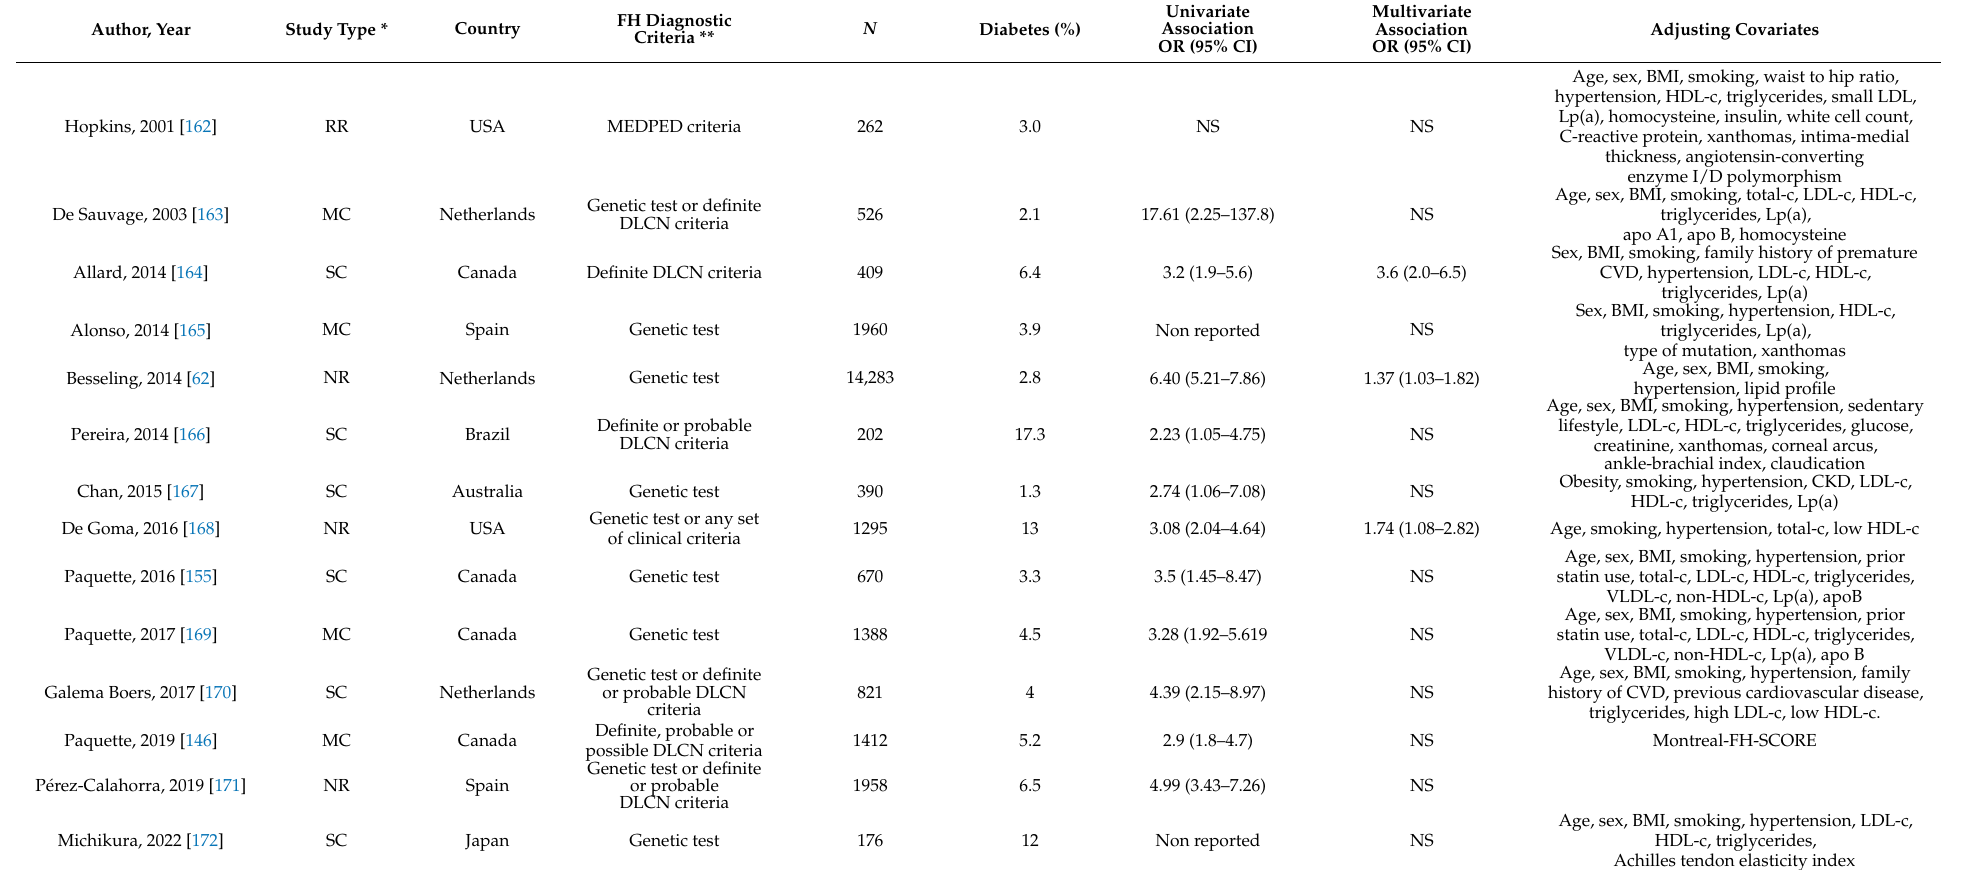
Cross-sectional studies that have assessed the association between diabetes and cardiovascular disease in subjects with heterozygous familial